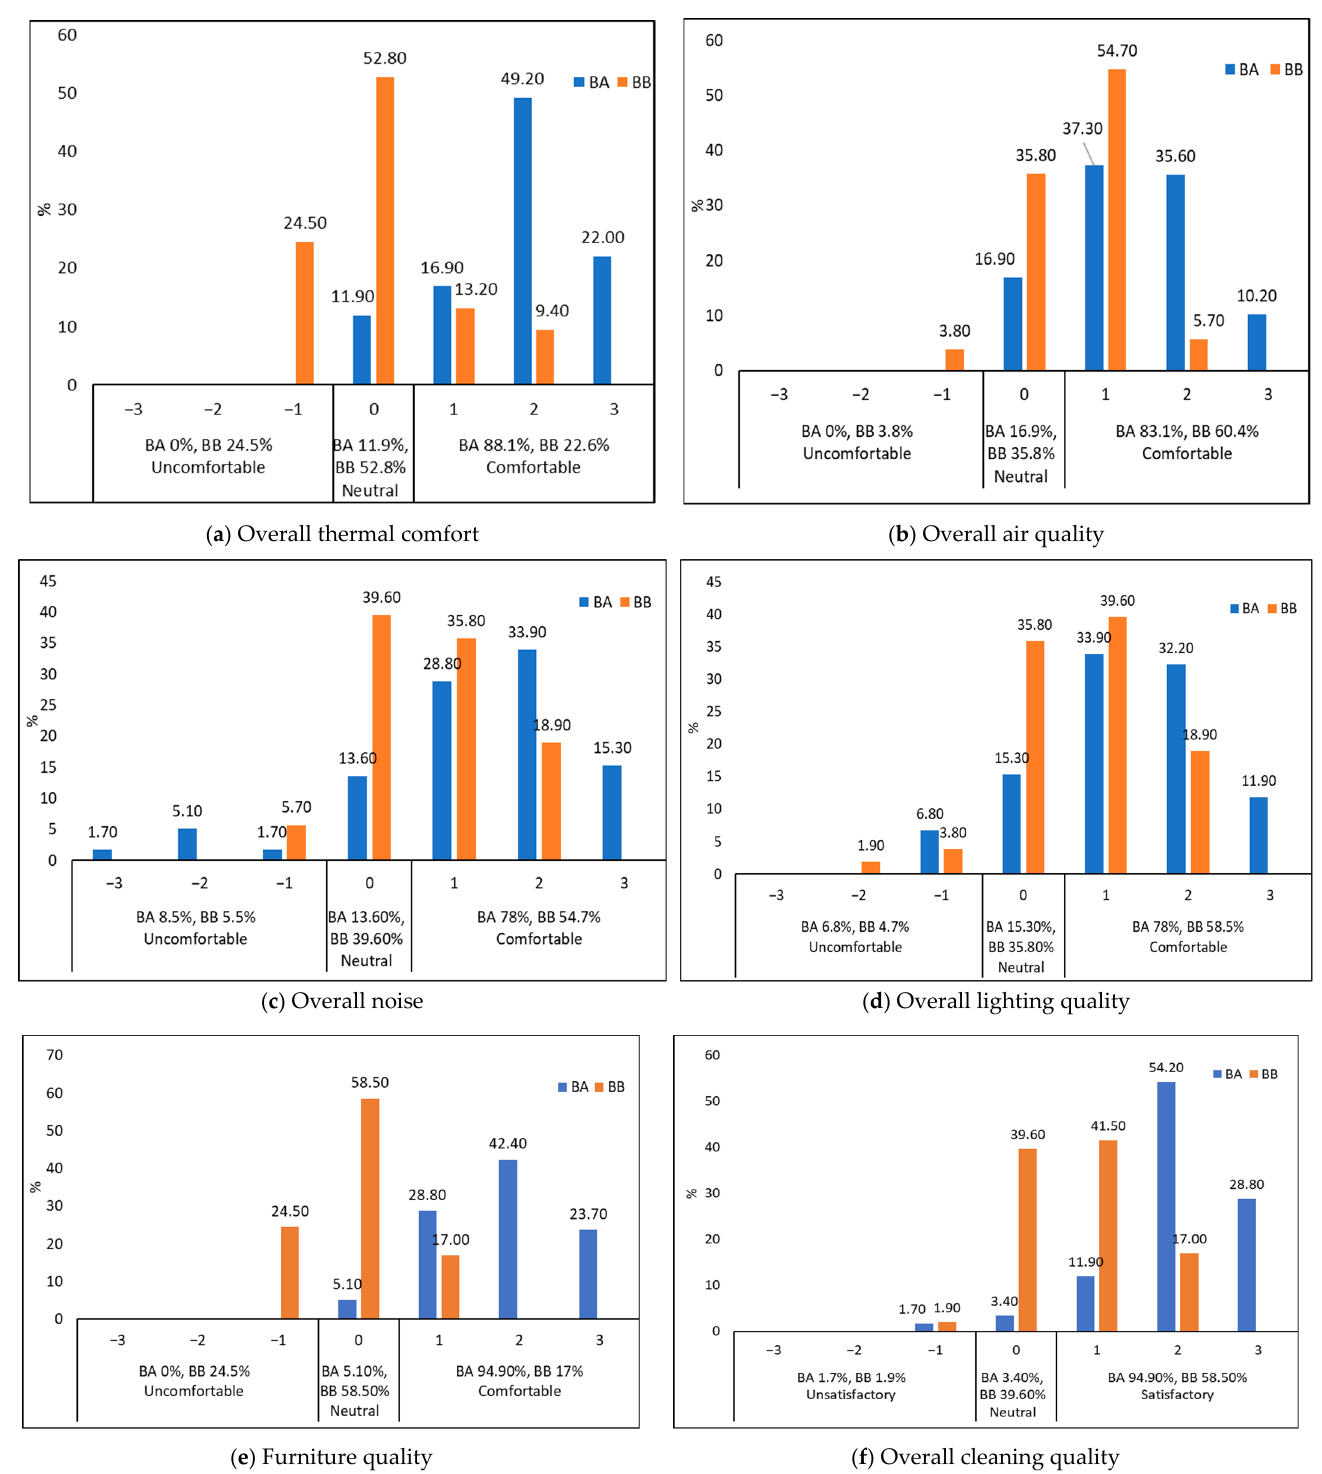
Figure 5. Frequency distribution of occupants’ votes over IEQ parameters. Satisfaction from overall thermal comfort is measured using a seven-point scale from uncomfortable to comfortable. This gives an overview of the portion of the occupants satisfied with thermal comfort. The finding indicated that 88.1% of respondents reported overall thermal comfort for building A, but 22.6% of respondents reported overall thermal comfort for building B. There is no thermal comfort dissatisfaction report of building A, whereas 24.5% of thermal comfort dissatisfaction was observed for building B (Figure 5a).